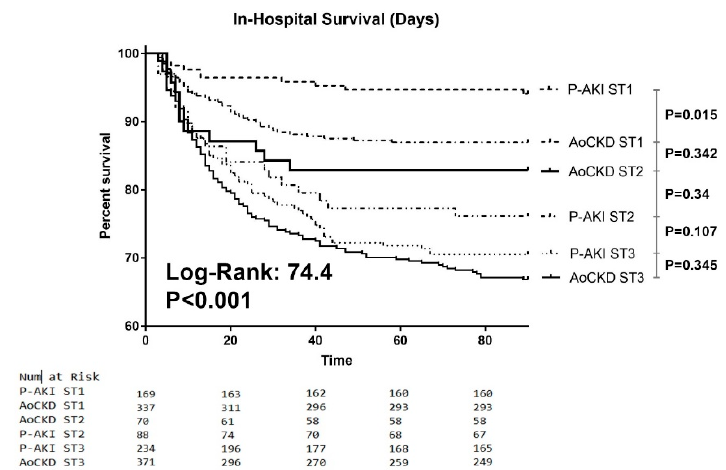
Figure 2 . Kaplan-Meier curves. In-hospital survival curves stratified by baseline renal function and AKI severity. P-AKI: Pure Acute kidney injury. AoCKD: Acute-on-chronic kidney disease. AKI: Acute kidney injury. ST1: AKI stage 1. ST2: AKI stage 2. ST3: AKI stage 3.